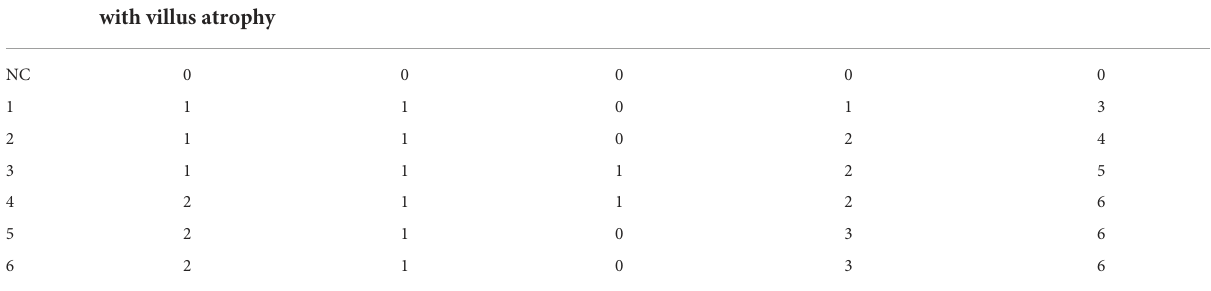
TABLE 4 Histopathological evaluation of intestinal sections from Prohemistomum vivax -infected pigeons. Group Inflammation Inflamed area/extent Surface ulceration Involvement percentage with villus atrophy